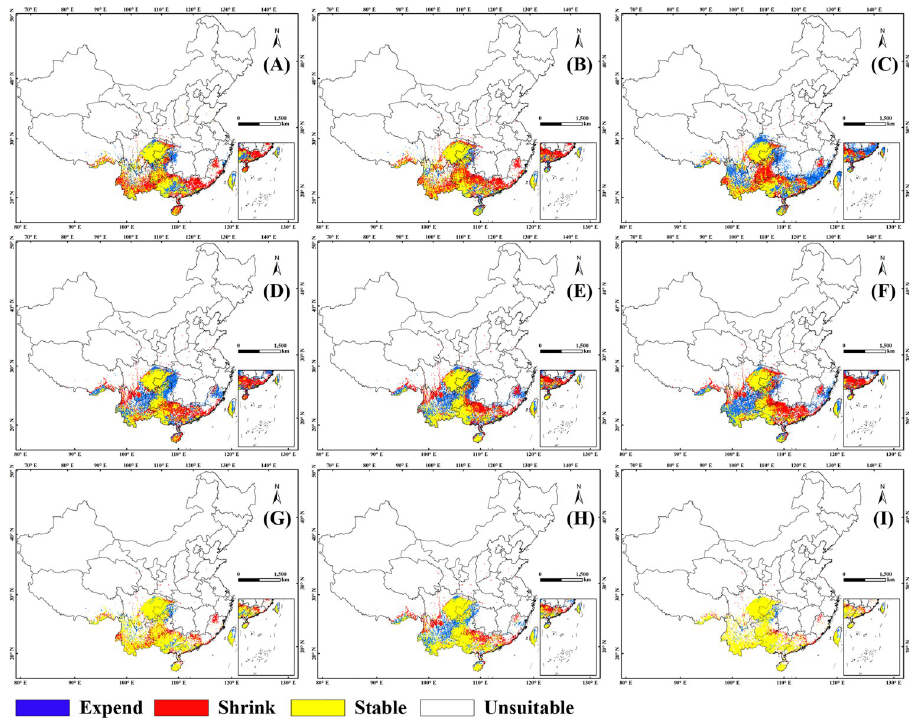
Fig 4. Changes in distribution of suitable habitats in the future. (A): 2050s, SSP1-2.6; (B): 2050s, SSP2-4.5; (C): 2050s, SSP5-8.5; (D): 2090s, SSP1-2.6; (E): 2090s, SSP2-4.5; (F): 2090s, SSP5-8.5; (G): 2050s; (H): 2090s; (I): 2050s~2090s. The boundary was obtained from Natural Earth (http://www.naturalearthdata.com/). Based on the principle of national and territorial integrity, we have modified and adjusted the vector boundary.